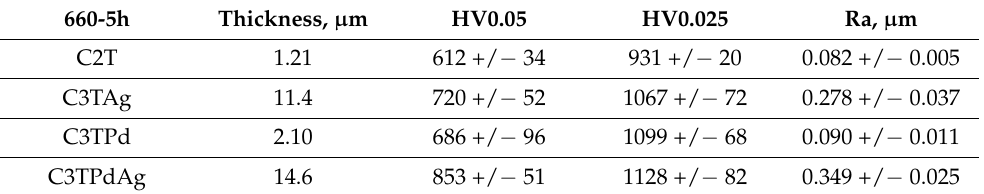
Figure 3. Surface morphology (left) and layer structure (right) of 660 ◦ C, 5h treated Ti6Al4V samples: ( a ) no catalytic layer; ( b ) with Ag, ( c ) Pd and ( d ) PdAg catalytic pre-depositions. Table 2. Surface layer thickness, hardness and roughness for 660 ◦ C-5 h treated samples with and without pre-coating elements (for sample code details see Table